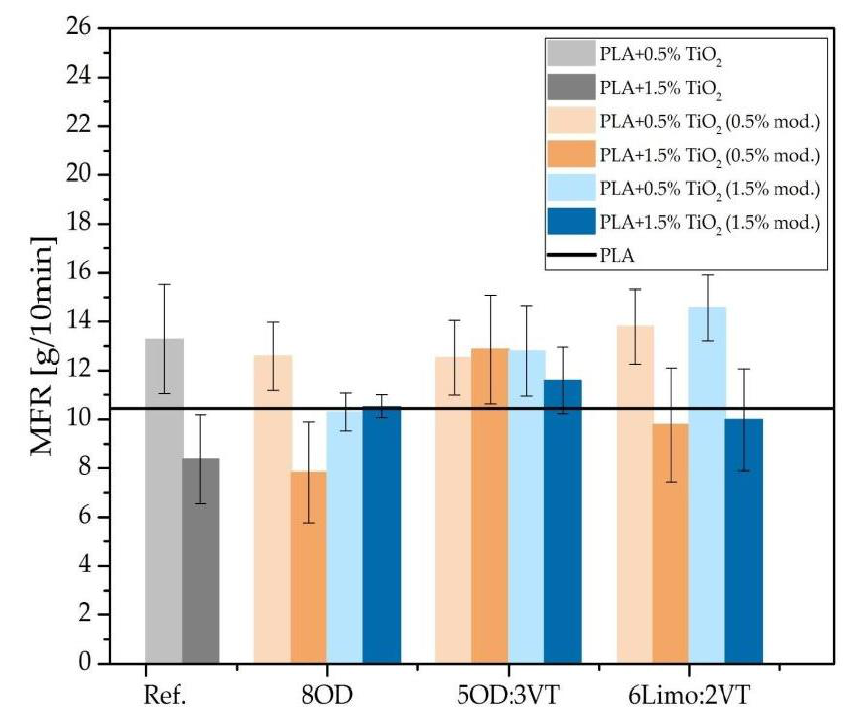
Figure 7. Results of the Mass Melt Flow Ratio Measurements.